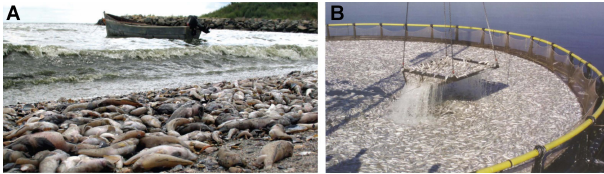
Fig. 19. ( A ) Mass mortality of benthic fauna in July 2010 in a semi- enclosed bay on Constanta beach (Photo: Adrian Teaca). ( B ) Dead fish floating in a cage after a massive fish kill in fish farms at Amvrakikos Gulf (February